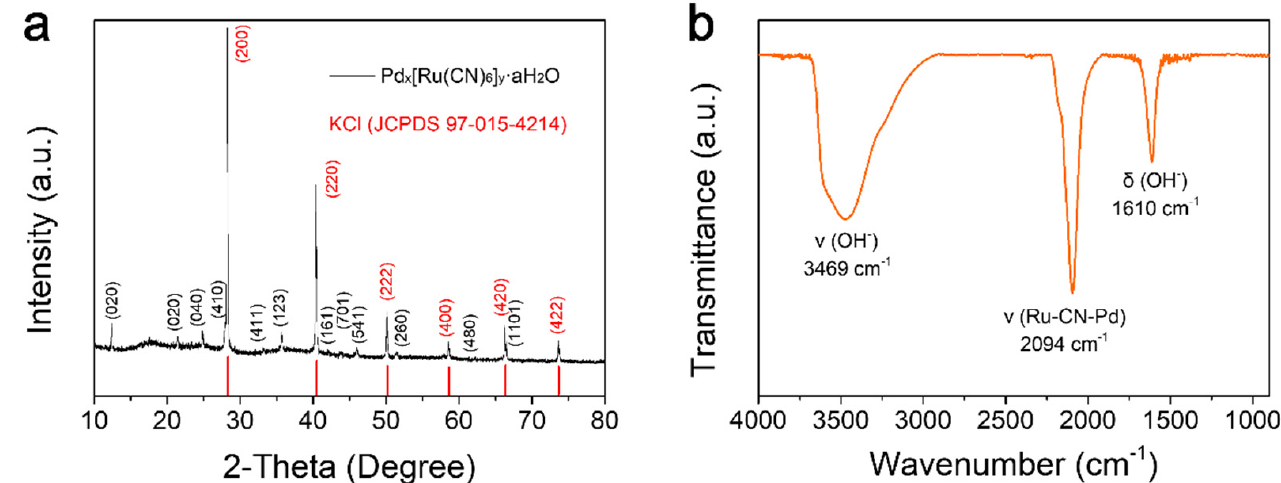
Figure 1. ( a ) X ‐ ray diffraction (XRD) pattern and ( b ) Fourier transform infrared (FT ‐ IR) spectrum of Figure 1. ( a ) X-ray diffraction (XRD) pattern and ( b ) Fourier transform infrared (FT-IR) spectrum of Pd x [Ru(CN) 6 ] y ∙ aH 2 O aero ‐ cyanogel. Pd x [Ru(CN) 6 ] y · aH 2 O